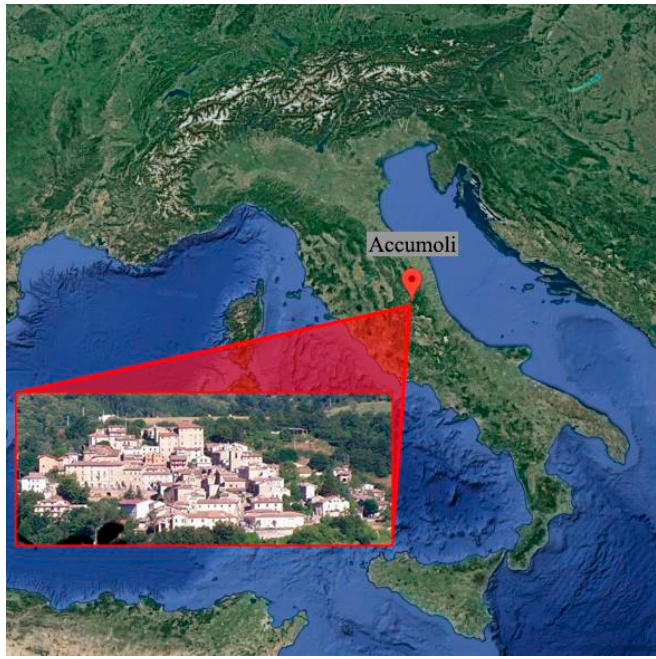
Figure 1. The Accumoli village (Central Italy).